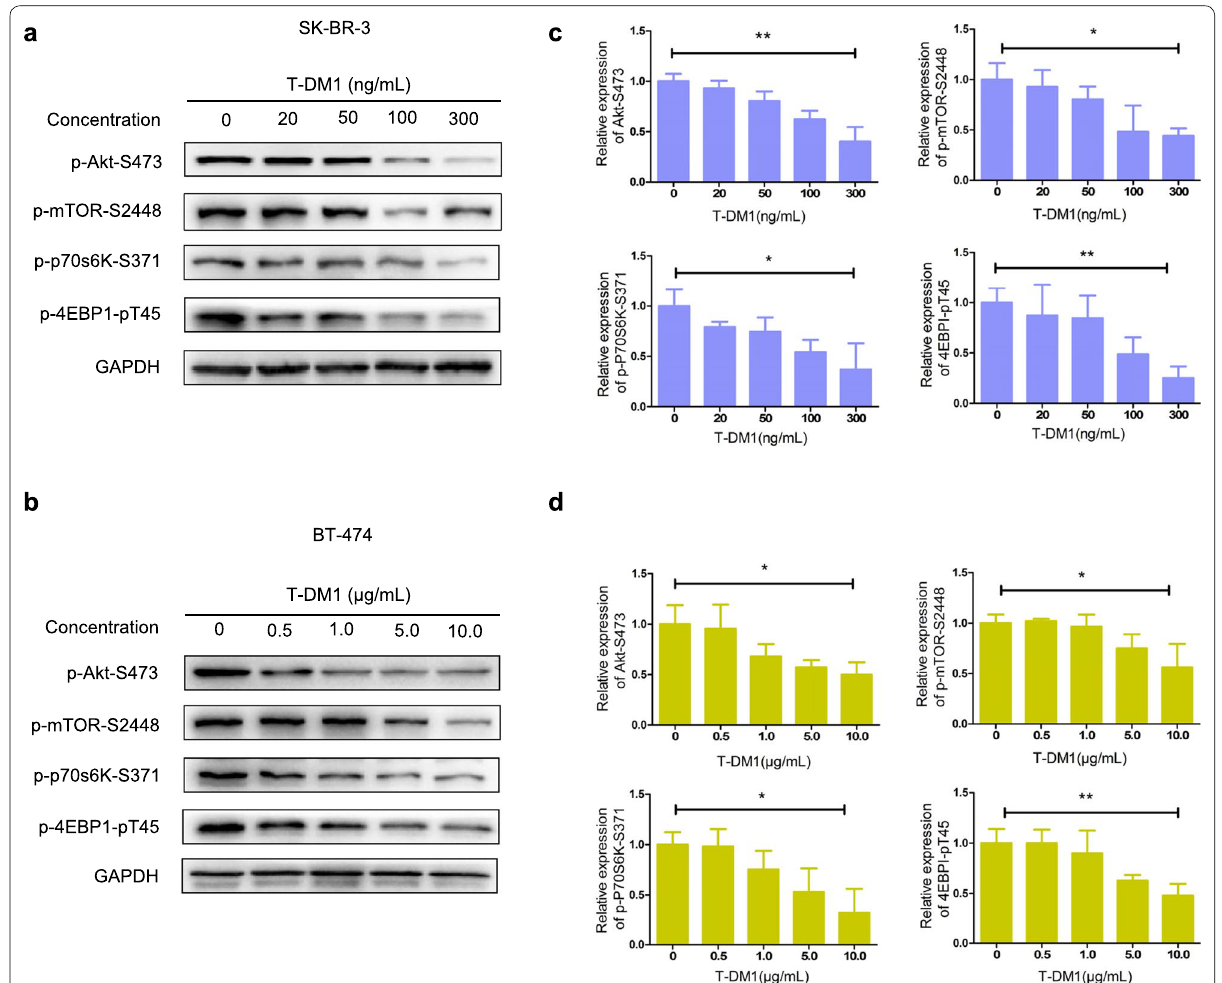
Fig. 5 Akt/mTOR signaling pathways were associated with T-DM1-induced autophagy in both two cells. a SK-BR-3 cells were incubated with 0, 20, 50, 100 and 300 ng/mL of T-DM1 for 48 h, and the protein expression levels of p-mTOR-S2448, p-p70s6K-S371, p-4EBP1-pT45, Akt and p-Akt-S473 were determined by western blot analysis. b Relative protein expression levels compared to GAPDH were showed in bar charts. c Protein expression levels were determined by western blot, after BT-474 cells being cultured with indicated concentrations of T-DM1 for 2 days. d Relative protein expression levels of BT-474 cells were presented in bar